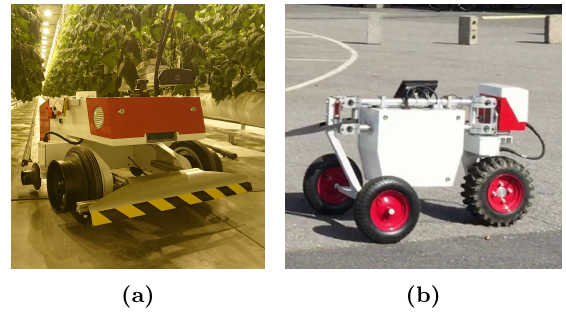
Figure 2: Small robots created with Thorvald II modules. ( a ) A differential drive robot for greenhouses. This robot has a simple custom frame made from sheet metal. ( b ) A one-wheel drive, one- wheel steering robot.